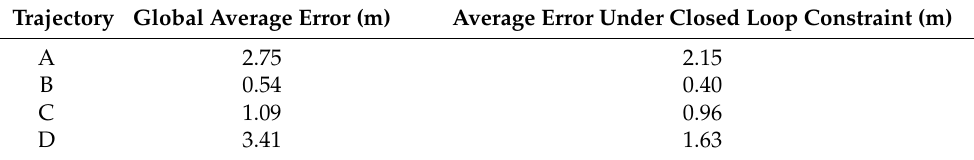
Table 1. Accuracy of each